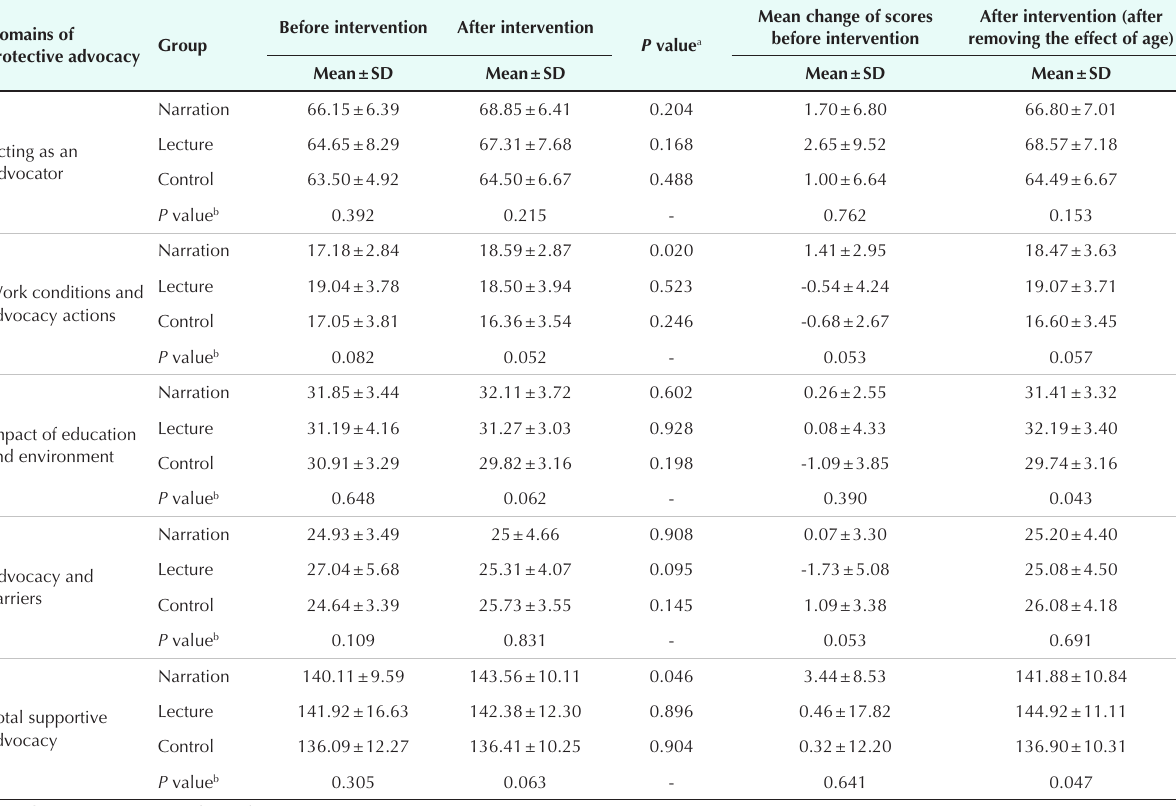
Mean change of scores before P value a